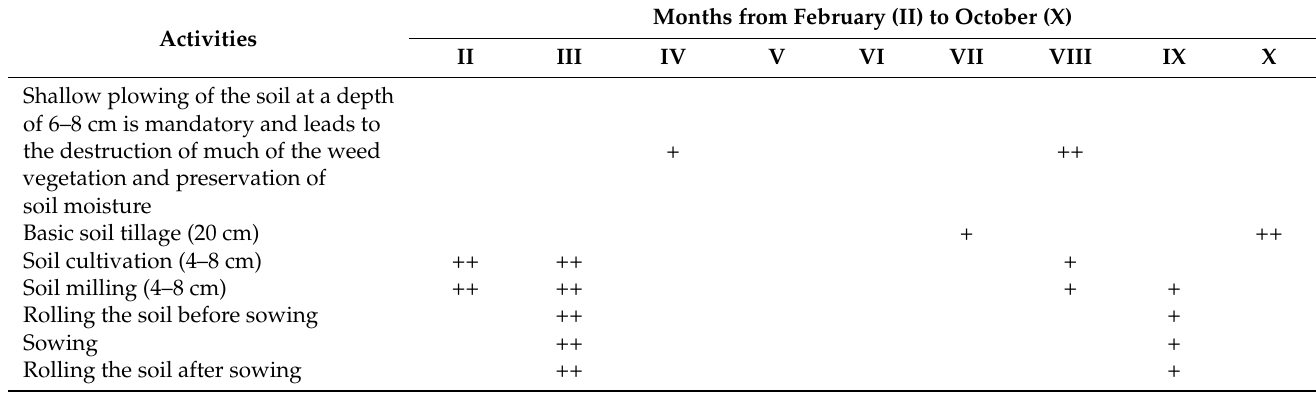
Table 1. Calendar of the main agro-technical activities in creating grass stands (according to the climate in